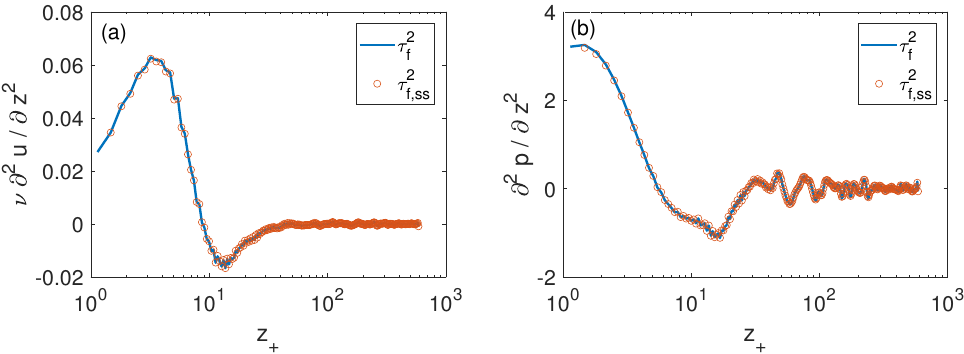
Figure 6. ( a ) Commutation error at primary filter level f for the second derivative (viscous term) ν∂ 2 u / ∂ z 2 together with the corresponding scale similarity model. ( b ) Commutation error at primary filter level f for the second derivative ∂ 2 p / ∂ z 2 appearing in the Poisson equation of the projection method together with the corresponding scale similarity